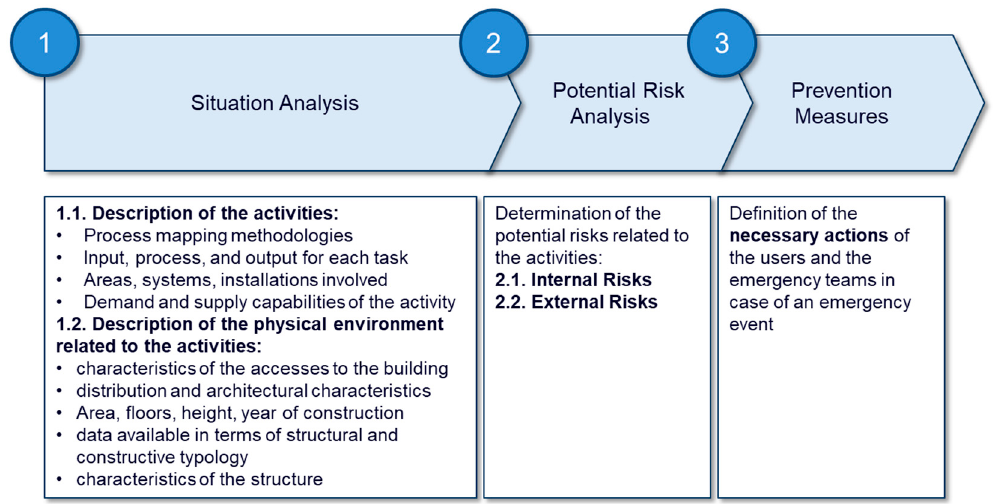
Figure 3. The 3-Steps Model for Developing Self-Protection Plans (own elaboration).